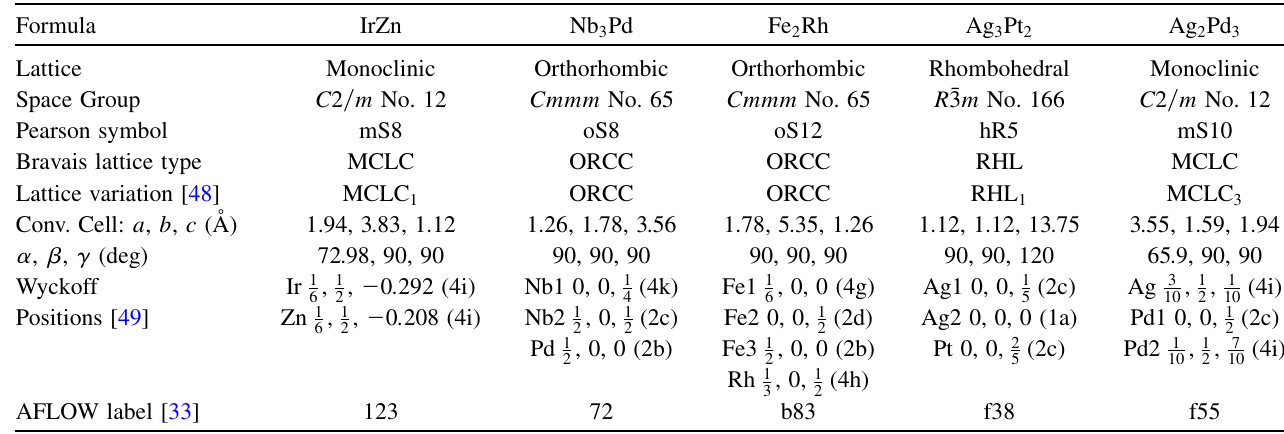
TABLE VII. Geometry of new prototypes marked by y in Tables III, IV, V, and VI.